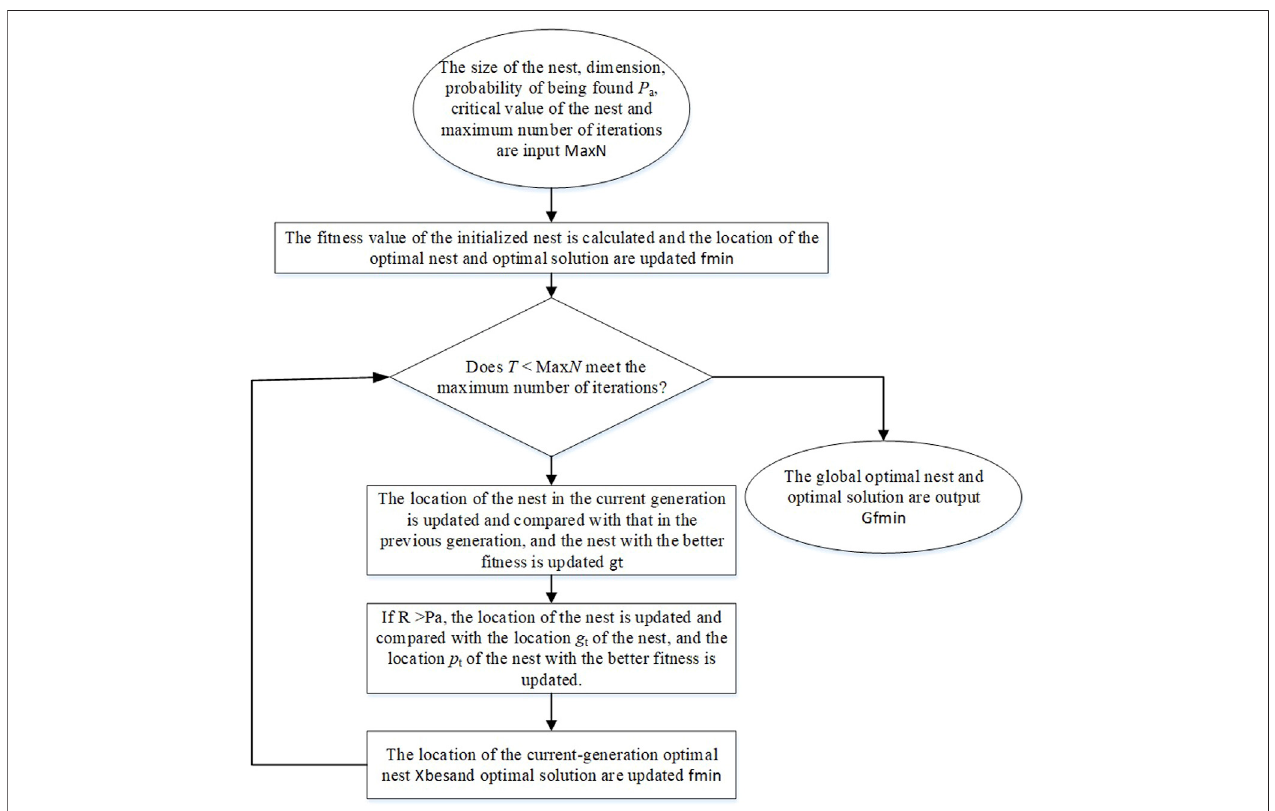
FIGURE 1 | Flow-chart through the ICS algorithm.